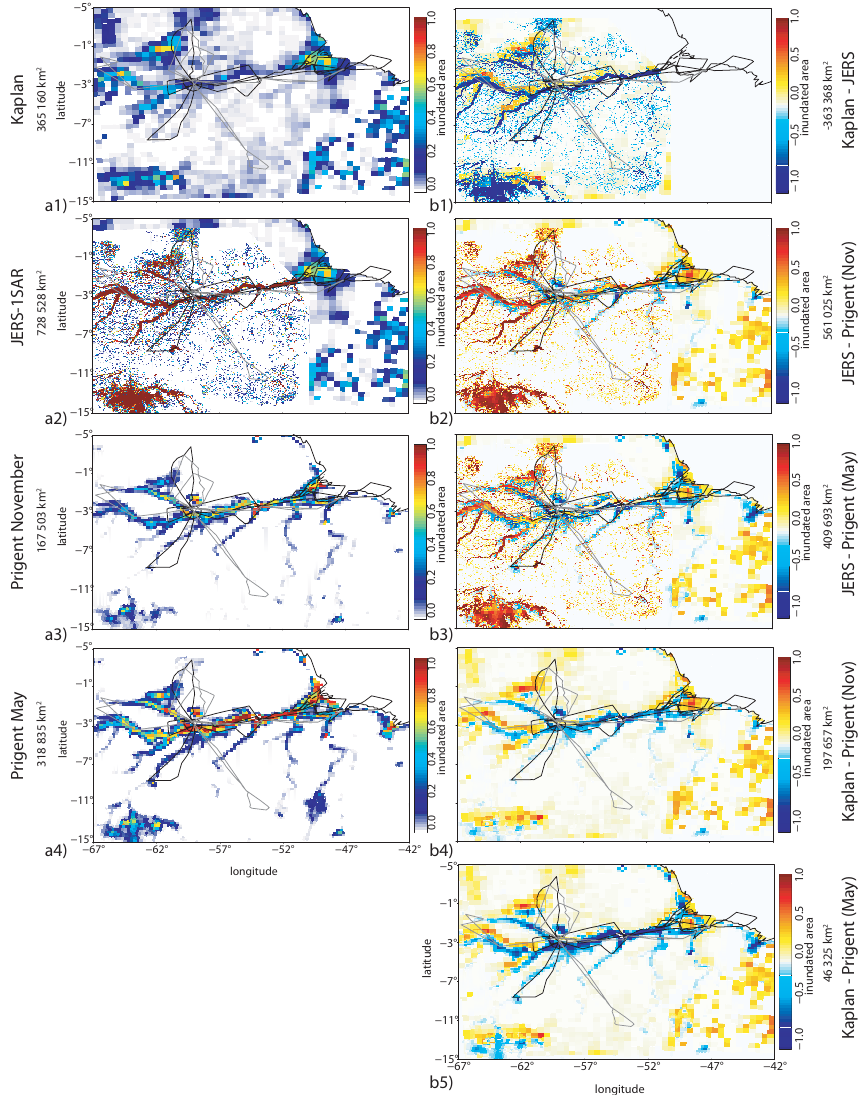
Fig. 2. Illustrated are three different wetland inundation maps (a) and the differences between these three wetland inundation maps (b) . The wetland inundation maps indicate the fraction of inundated area per grid cell ranging from 0 to 1 and − 1 to 1 for the differences between the wetland inundation maps. They are projected on the WRF nested grid (10km horizontal grid distance). The BARCA flight tracks are overlaid (BARCA-A – black, BARCA-B – grey). (a1) denotes the Kaplan wetland map with a original horizontal resolution of 0.5 ◦ × 0.5 ◦ , (a2) the JERS-1SAR product with a original 3 arcsec horizontal resolution for the Amazon lowland area ( < 500m) combined with the Kaplan potential wetland map, (a3) the Prigent wetland map for November (mean wetland inundation map for November of the years 1997–2003) on an original horizontal resolution of 0.25 ◦ × 0.25 ◦ , and (a4) the same map of the multi-annual average for May. In (b1) – (b5) , the differences between the single wetland inundation maps are demonstrated. The numbers illustrates the total inundated wetland area or difference in the inundated wetland area for the d02